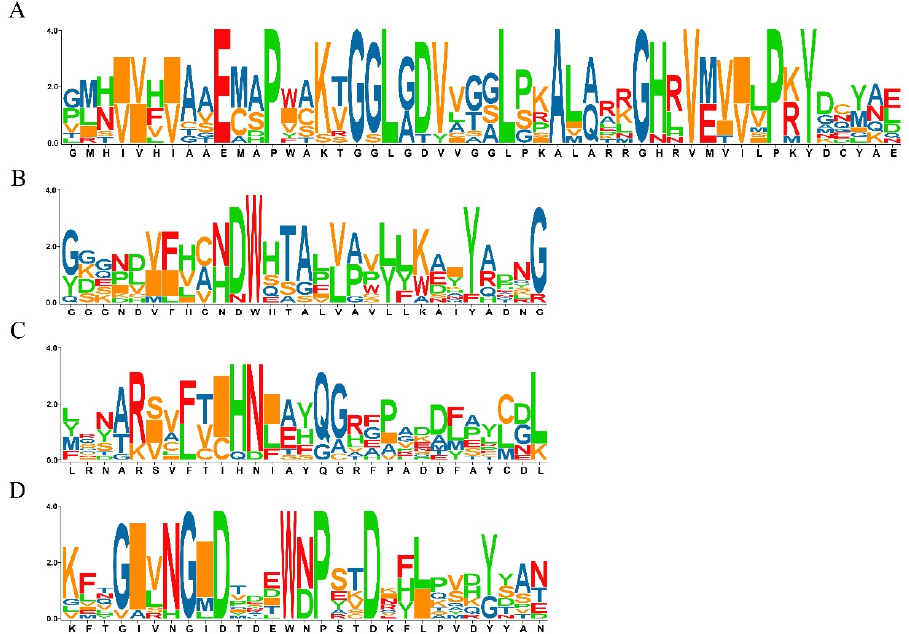
Figure 1. List of putative motifs of the OsSS gene family. ( A ) motif 1; ( B ) motif 2; ( C ) motif 3; ( D ) motif 4. The size of letters represents the similarity of amino acids during multiple sequence alignments, while a single letter indicates that the amino acid is completely